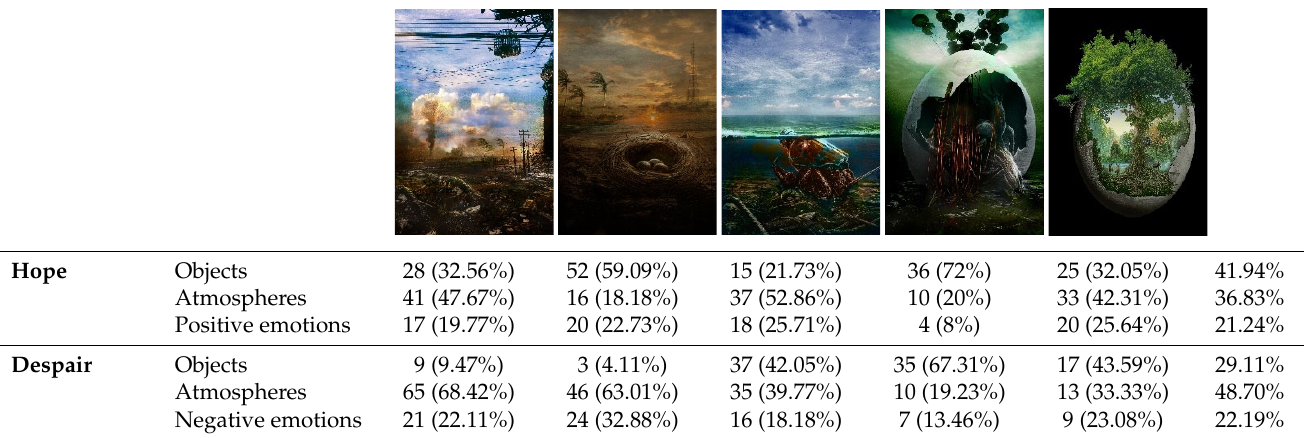
Table 7. Percentage of objects, atmospheres, and emotions on color images expressing hope and despair.